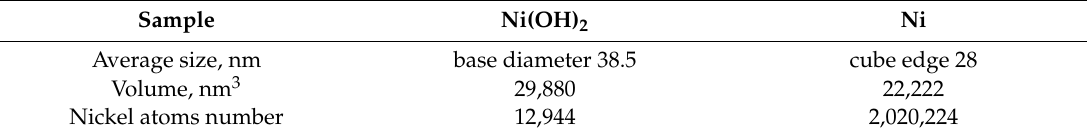
Table 5. Estimation of the number of nickel atoms in the samples.